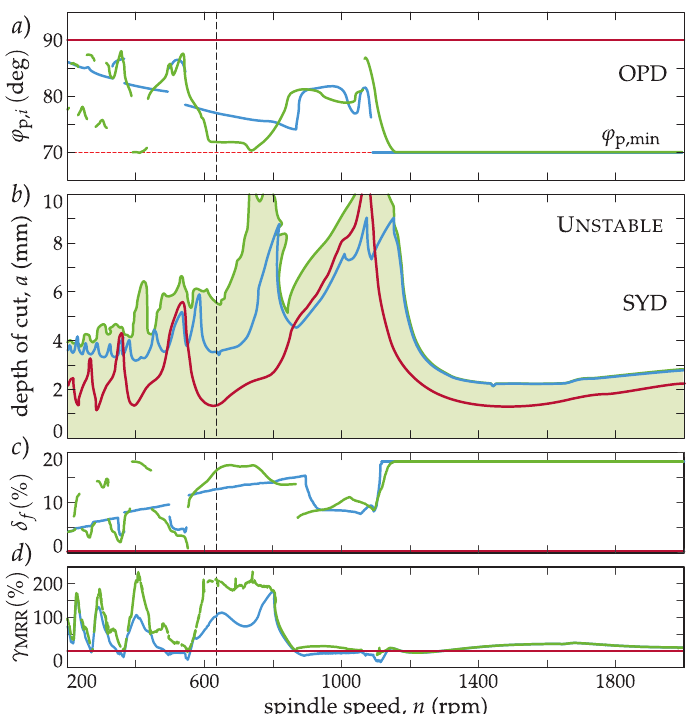
Figure 5. ( a ) Optimal pitch angle chart (OPD), ( b ) stabilizability diagram (SYD), ( c ) relative feed load drop, δ f , while in ( d ), the relative material removal rate (MRR) gain, γ MRR , are presented (green: BF-1A, red: regular, blue: BS, and ϕ p,min = 70